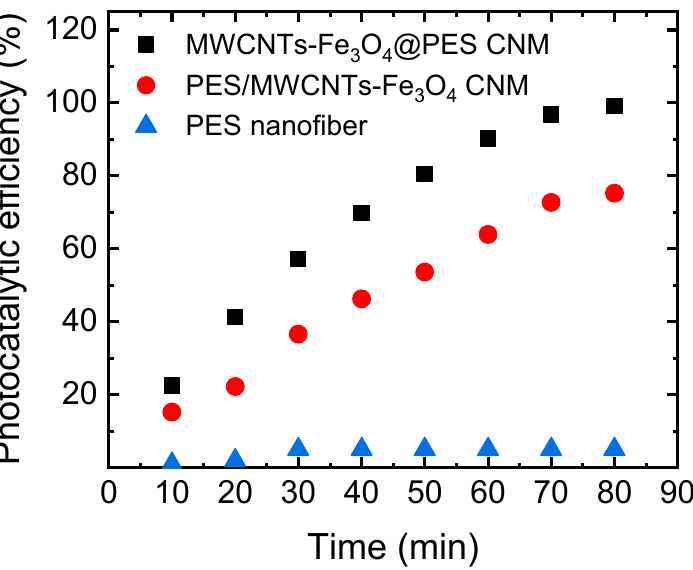
Figure 4. Photocatalytic efficiency of Cr(VI) using PES nanofiber, PES/MWCNTs-Fe 3 O 4 CNM, and MWCNTs-Fe 3 O 4 @PES CNM.